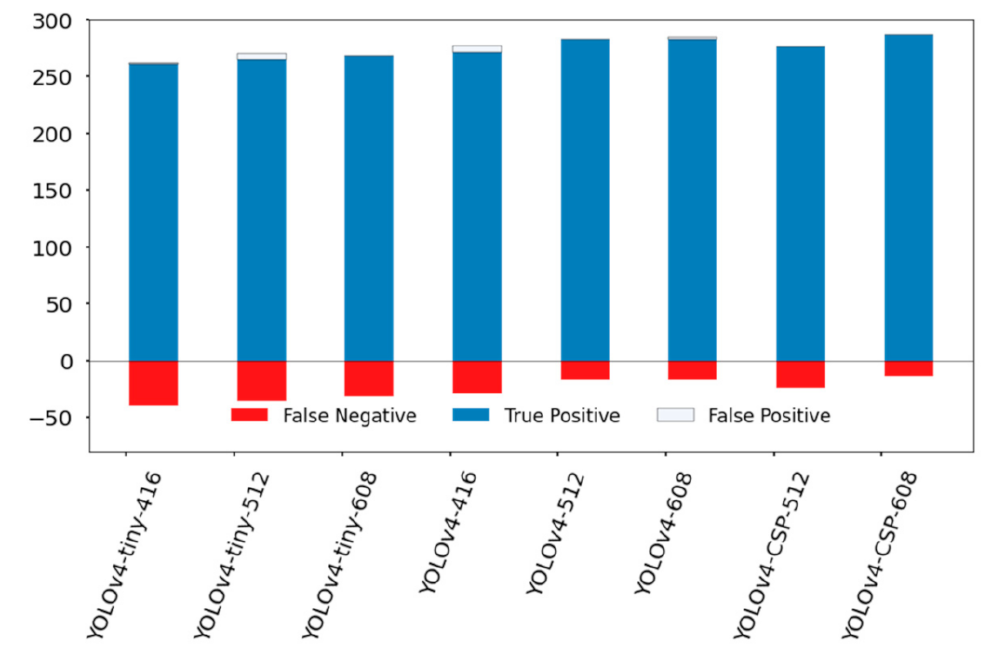
Figure 14. Comparison of YOLOv4 models in terms of the frequency of True Positive, False Positive, and False Negative detections. The specific values are in Table